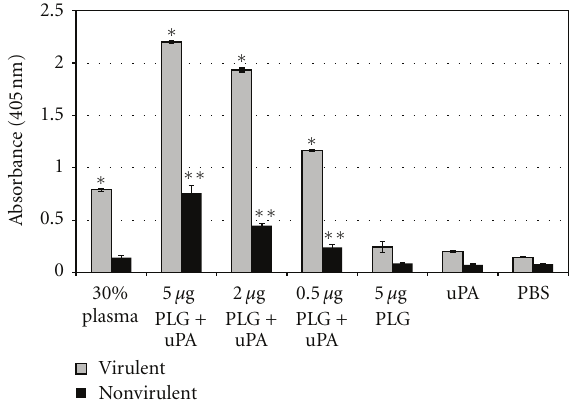
Figure 2: Cleavage of the plasmin-specific chromogenic substrate by plasmin-bound leptospires. Live low-passage virulent and high-passage nonvirulent L. interrogans serovar Copenhageni cells received the following treatments: PBS only (PBS), uPA alone (uPA), 5 μ g PLG alone (PLG), PLG in crescent quantities (0.5, 2 and 5 μ g) together with uPA, and 30% human plasma together with uPA (30% plasma). Bars represent mean absorbance as a measure of relative substrate degradation ± the standard deviation of three replicates for each experimental group and are representative of three independent experiments. ∗ Virulent leptospires experiments: statistically significant ( P < 0.0001) in comparison to the PBS con- trol; ∗∗ nonvirulent leptospires experiments: statistically significant ( P < 0.01) in comparison to the PBS control. The 30% plasma, as PLG source, and all the PLG + uPA samples of the virulent leptospires were statistically significant ( P < 0.001) in comparison to the same nonvirulent bacteria tested samples.